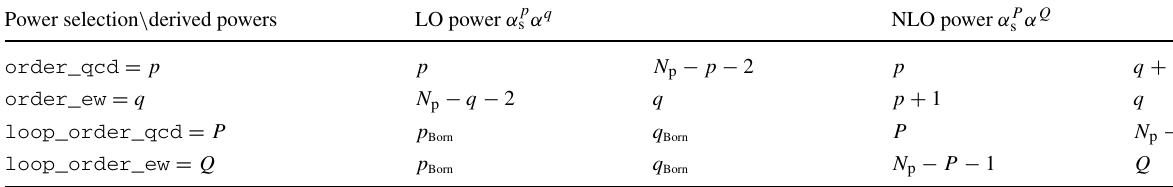
of external particles. The loop_order selectors are supported only for amptype=11 . They return the desired loop–tree interference of α Q ) together with the dominant underlying squared Born term O (α P s of O (α p s α q ) whose powers, ( p , q ) = ( p Born , q Born ) = ( P − 1 , Q ) or ( P , Q − 1 ) , are selected in a unique way as indicated in Fig. 4